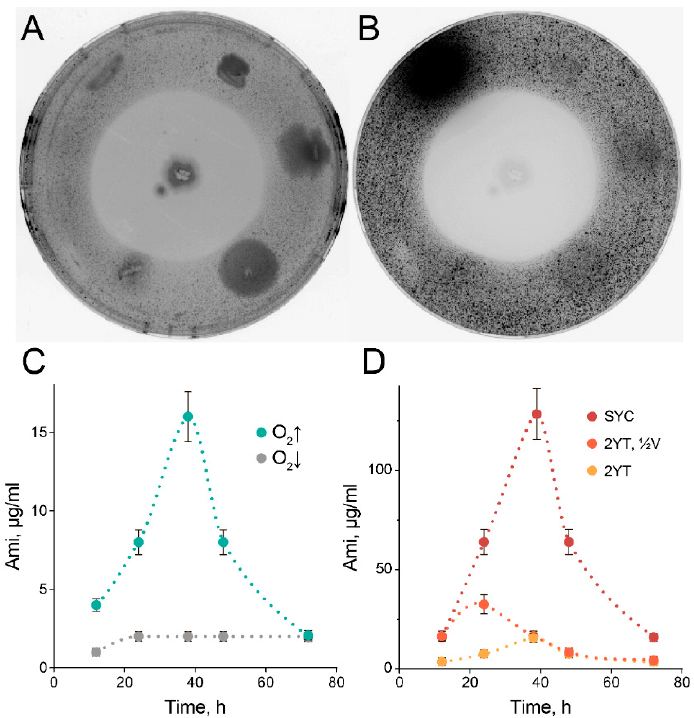
Figure 2. The selected Bacillus pumilus efficiently produce Ami. Cultivation of Ami-producing B. pumilus on agar causes the appearance of substantial zones of clearance. The clearance zones were observed with the agar overlay assay using a reporter Staphylococcus aureus strain producing GFP in visible light ( A ) and by fluorescence analysis of GFP ( B ). The colonies around B. pumilus (center) are the representative strains picked from the oral microbiome of brown bear, randomly. The data illustrate the representative view of three independent repeats. ( C ) Cultivation of B. pumilus in limited (grey) or high (aquamarine) aeration conditions. ( D ) Cultivation of B. pumilus at high aeration in SYC medium (red) and 2YT medium in the same volume (yellow) or in a twice reduced volume (orange). Ami concentration (dots) was estimated by an antibacterial activity assay of culture medium in triplicate. Data represent mean ± SD.